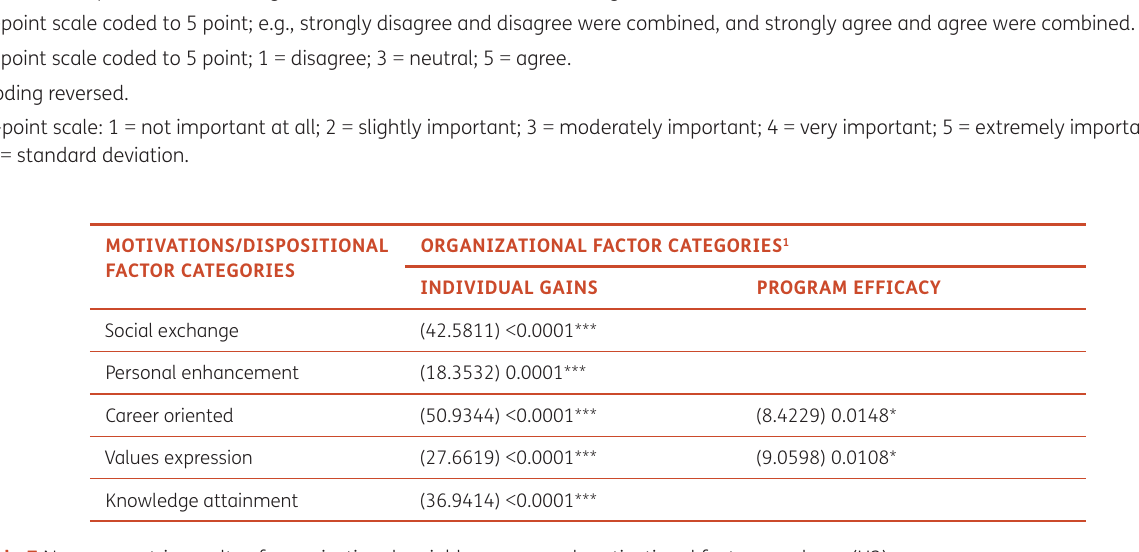
Table 7 Nonparametric results of organizational variable groups and motivational factors analyses